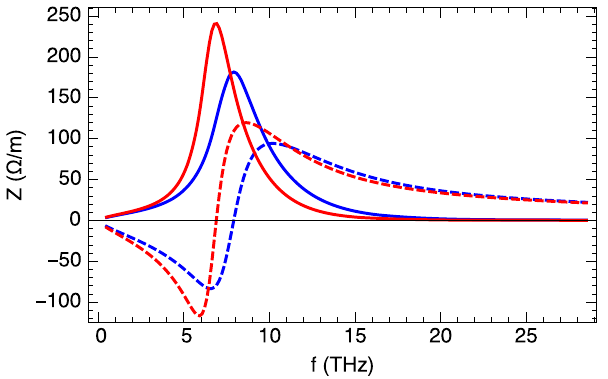
FIG. 3. For flat geometry: real (solid lines) and imaginary (dashed lines) parts of the impedance (9) for copper (red) and aluminum (blue).